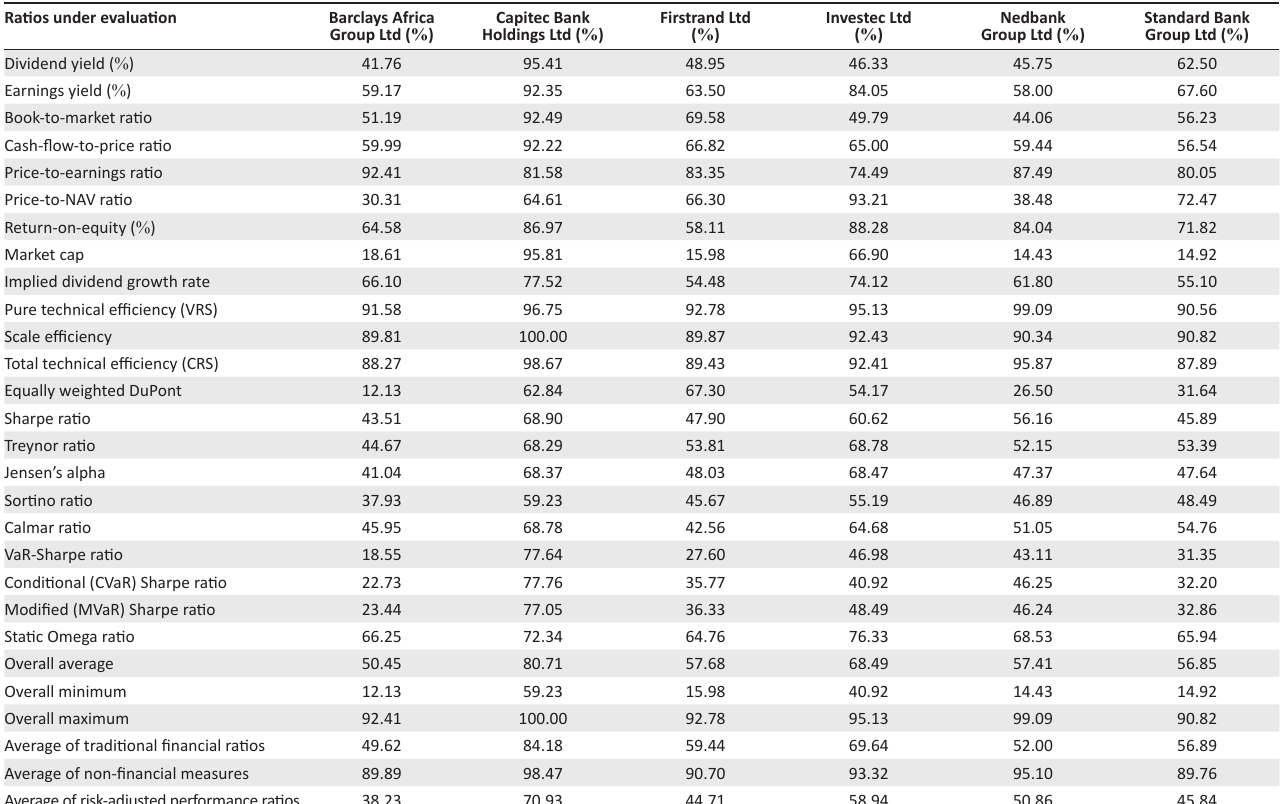
TABLE 5: Average explanatory ability of ratios to explain one year ahead share returns per bank. Ratios under